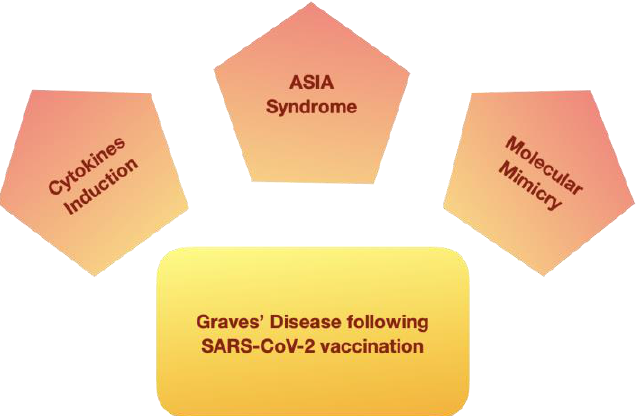
Figure 2. Potential pathogenetic mechanisms underlying the development of GD following SARS- CoV-2 vaccination.